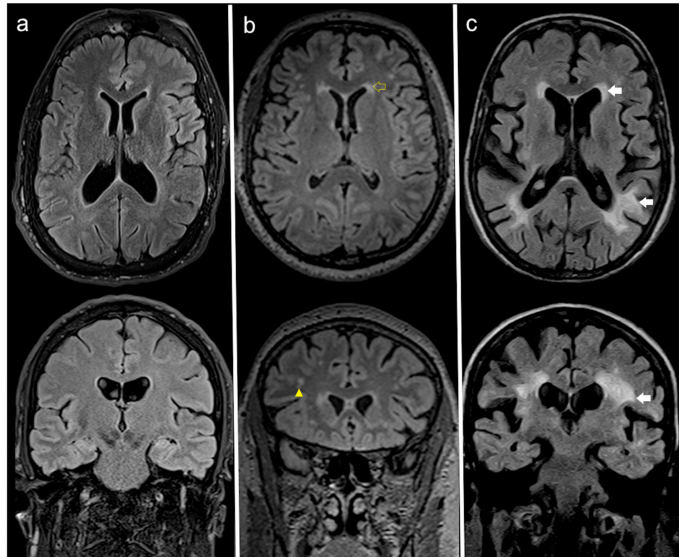
Figure 2. Axial (top) and coronal (bottom) FLAIR MRI at the most representative levels of three AFD patients with di ff erent degrees of white matter (WM) damage, respectively: ( a ) no WM involvement (52 years old woman with FS = 0); ( b ) moderate WML load (44 years old male patients scoring a FS = 3, with punctate foci of hyperintensity a ff ecting the deep WM—yellow arrowhead and smooth bilateral periventricular “halo”—yellow empty arrow); ( c ) high WML load (59 years old man scoring FS = 6, with largely confluent asymmetrical WMLs irregularly extending from periventricular to deep white matter white arrows and some scattered lacunar infarcts not shown). Legend: FLAIR = fluid attenuated inversion recovery; MRI = magnetic resonance imaging; AFD = Anderson-Fabry disease; WML = white matter lesion; FS = Fazekas’